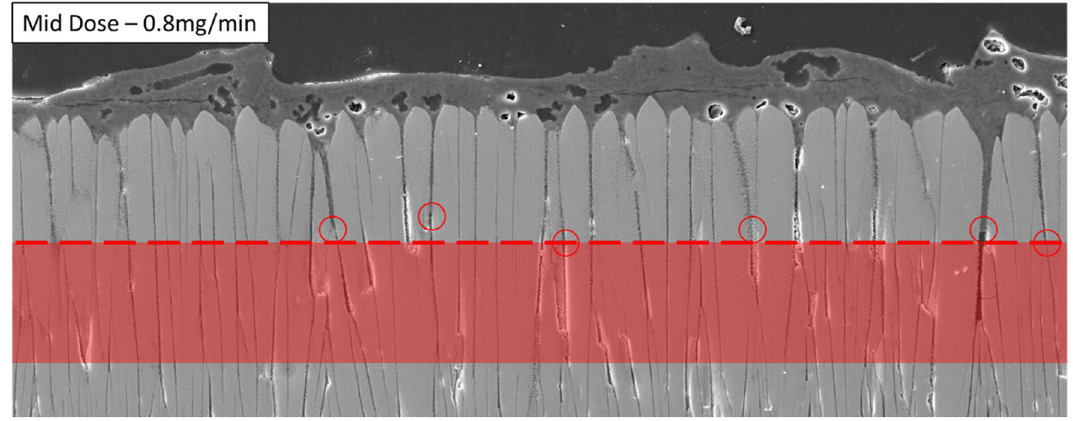
Fig. 4 Cross-section of medium deposition rate condition (0.8 mg/min) with several CMAS freeze locations circled in red. Dotted line indi- cates initial theoretical freeze line. Translucent band indicates potential movement of freeze line with CMAS